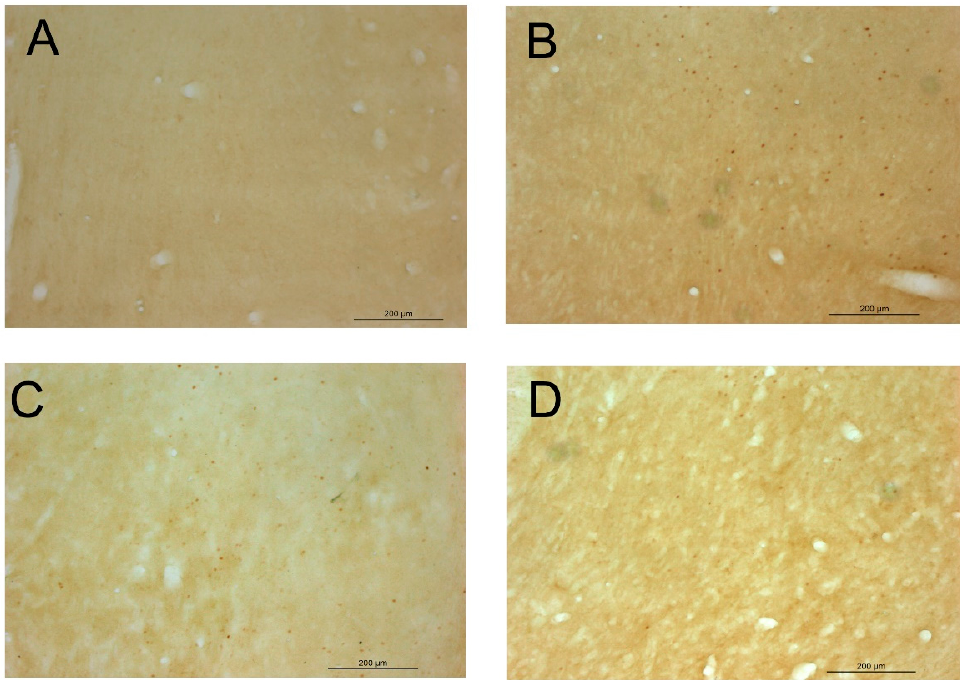
Figure 6. Representative images of coronal sections of the NAcc after cFOS staining in experiment 2. Legend: ( A ) group aCSF/Veh; ( B ) group aCSF/NAC 120; ( C ) group EtOH/Veh; ( D ) group EtOH/NAC 120.